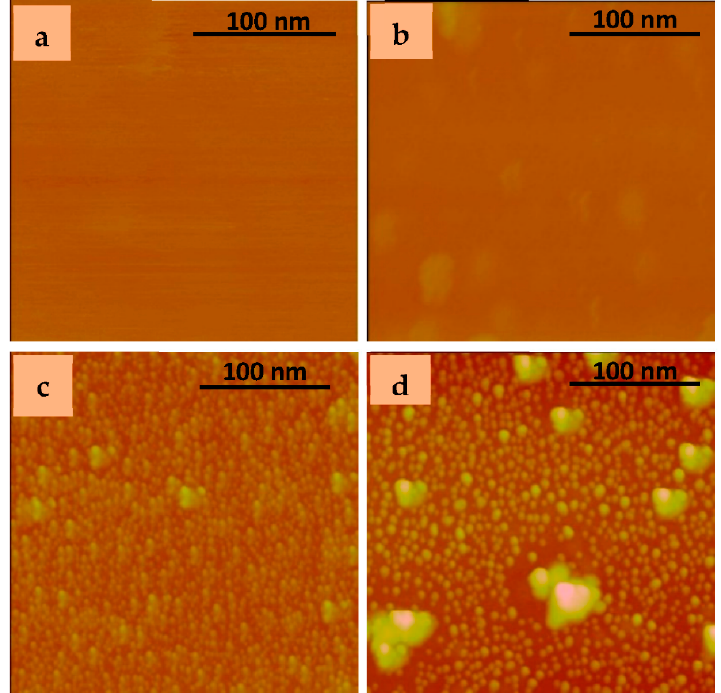
Figure 2. 2D Atomic Force Microscopy (AFM) images of ( a ) pristine a-C and ( b , c and d ) Ag:a-C nanocomposites at varying fluence of 2.5 ions/cm 2 , 3.0 ions/cm 2 and 3.4 × 10 16 ions/cm 2 , respectively.